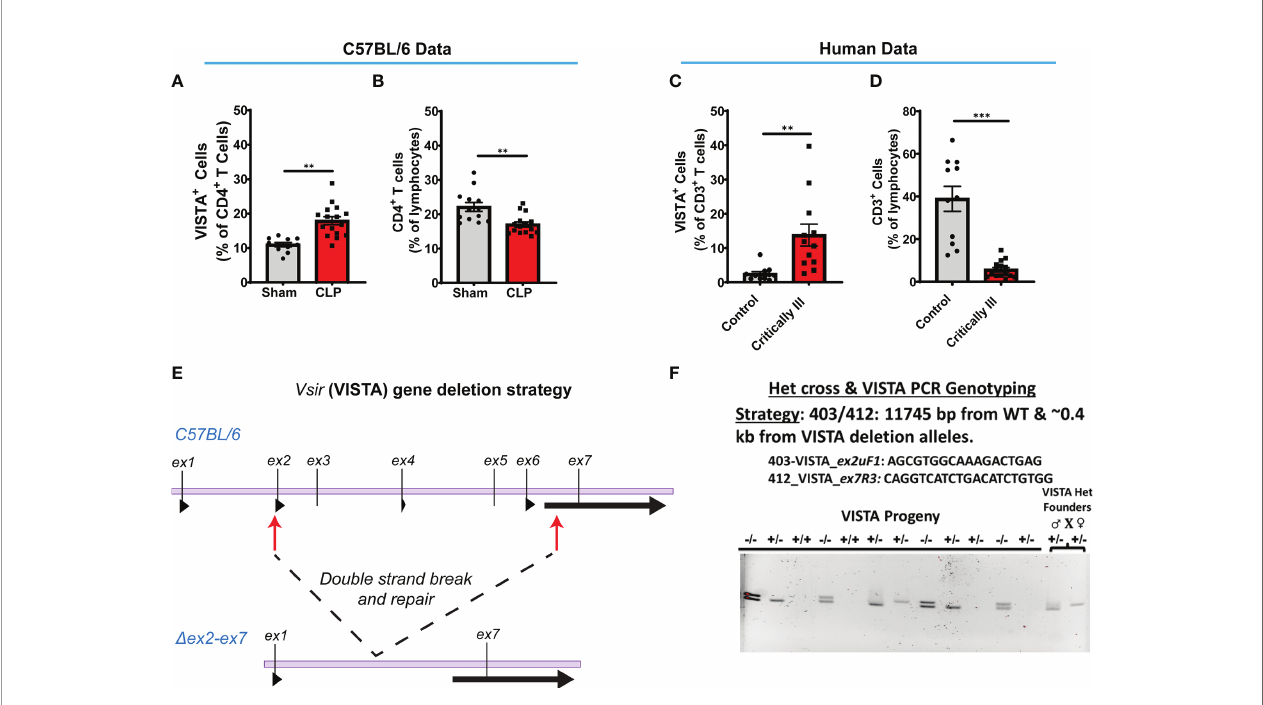
FIGURE 2 | VISTA + CD4 + T cells in mouse splenocytes and VISTA + CD3 + lymphocytes in patient blood increase following experimental or clinical sepsis. (A) Summary graph of VISTA + CD4 + T cells in the wild-type mouse spleen. (B) Summary graph of CD4 + T cell frequency in the wild-type mouse spleen. (C) Summary graph of VISTA + CD3 + T cell frequency in the peripheral blood lymphocytes. (D) Summary graph of CD3+ T cell frequency in the peripheral blood. (A – D) Summary graphs show mean ± SEM [WT-sham: n = 13 , WT-CLP: n = 16 ]; signi fi cance **p < 0.01, ***p < 0.001. (E) Initial process (Strategy) for producing embryos de fi cient in the ~11.3-kb region containing exon (ex) 2 to exon 7 of the VISTA gene on mouse chromosome 10 with CRISPR/Cas9 followed by NHEJ- mediated repair. (F) Results of initial heterozygous cross of VISTA -/+ founder mice resulting from CRISPR/Cas9 technology that produced homozygous VISTA -/- mice for breeding (PCR genotyping strategy: 403/412: 11,745 bp from WT and ~0.4 kb from VISTA deletion